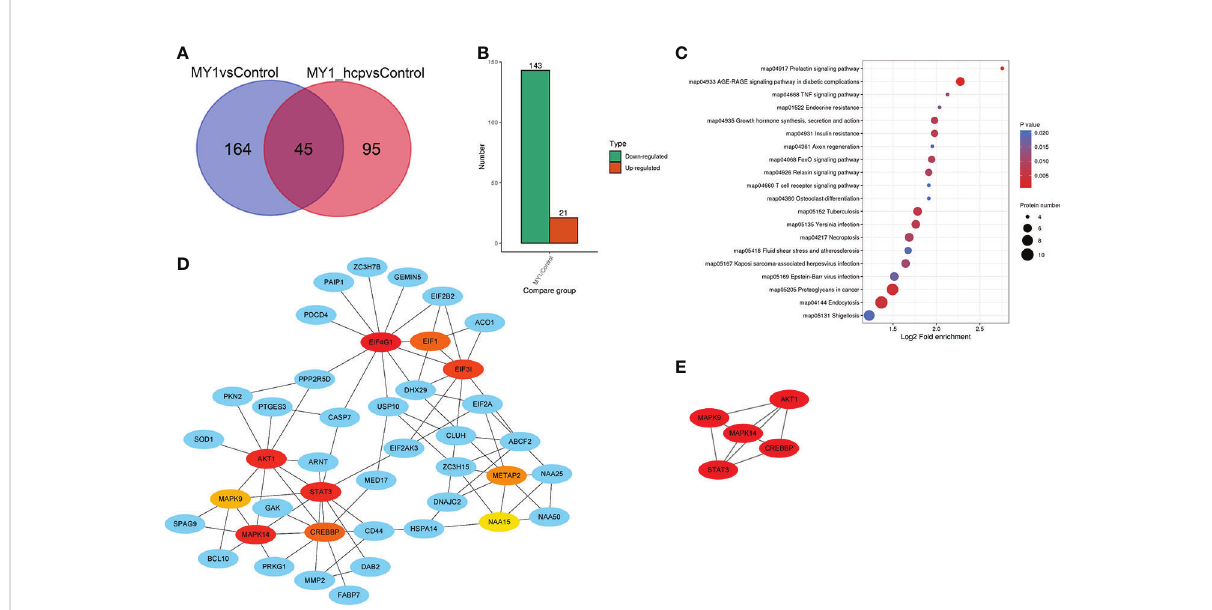
FIGURE 4 Differentially abundant proteins (DAPs) analysis between MY1-infected and MY1 △ hcp -infected dGCs. (A) Venn diagram of pairwise comparison of MY1-infected and MY1 △ hcp -infected dGCs sequencing samples. (B) Statistics of the number of DAPs. (C) Kyoto Encyclopedia of Genes and Genomes (KEGG) pathway analysis for the DAPs. P <0.05 was used as a threshold to select signi fi cant KEGG pathways. (D) The protein protein interaction (PPI) network of DEPs of top 10 with fi rst-stage neighbors. (E) According to cytoHubba plugin ’ s MCC ranking, the fi ve hub DAPs the fi ve hub DAPs of the PPI